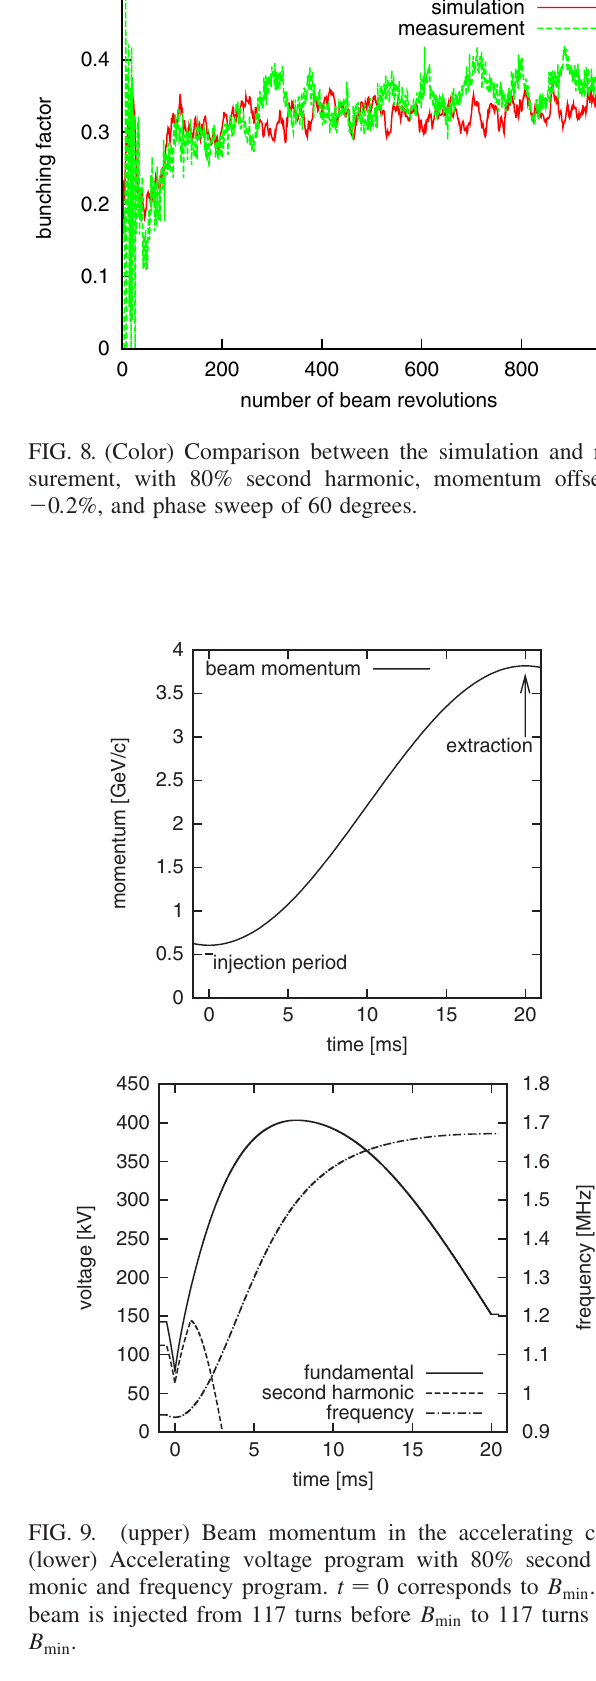
. The min to 117 turns after min